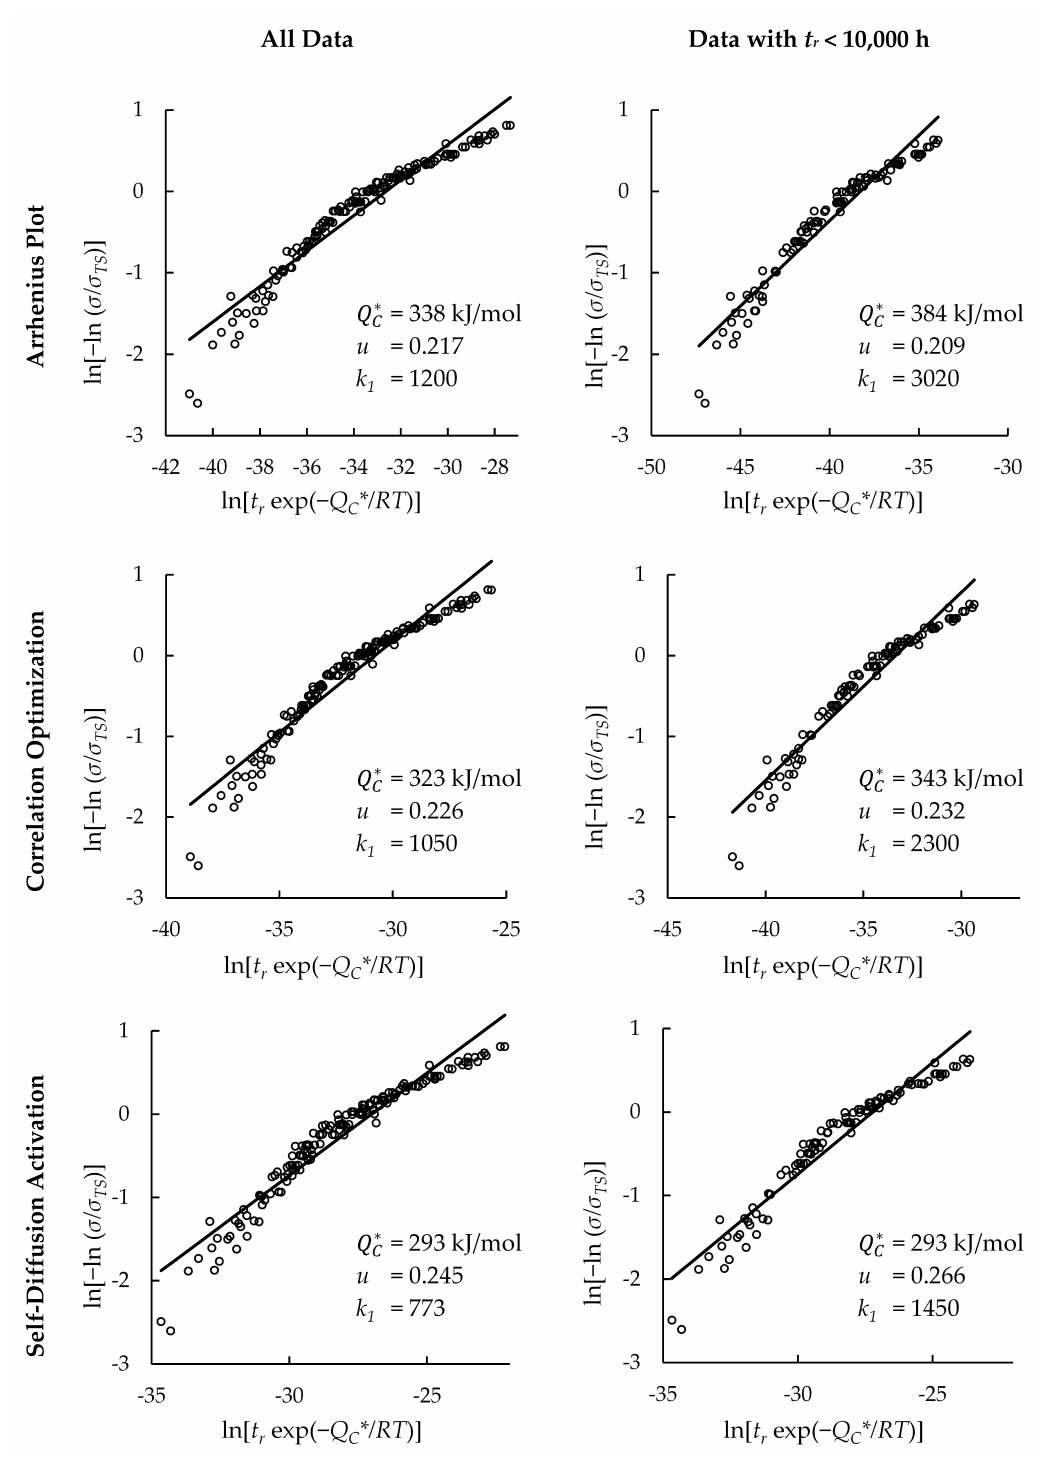
Figure A2. Goodness of fit of Sanicro 25 creep rupture data on Wilshire plots.